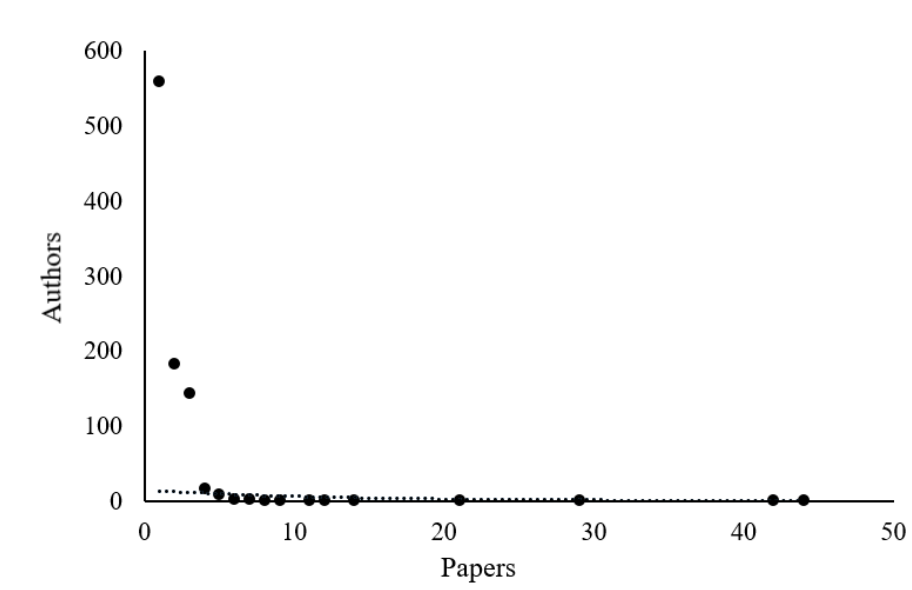
Figure 2. Correlation between authors (Y axis) and papers (X